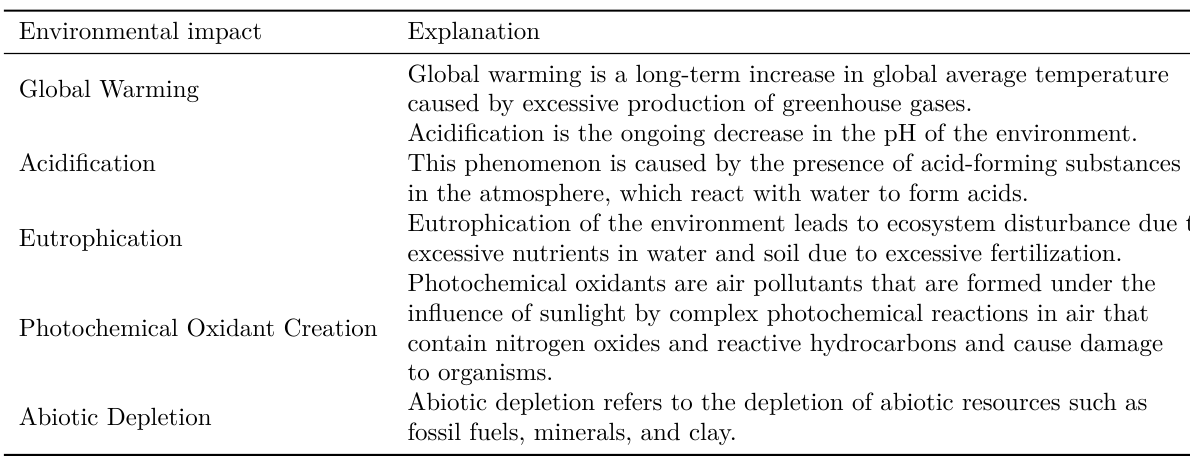
Table 2. Environmental